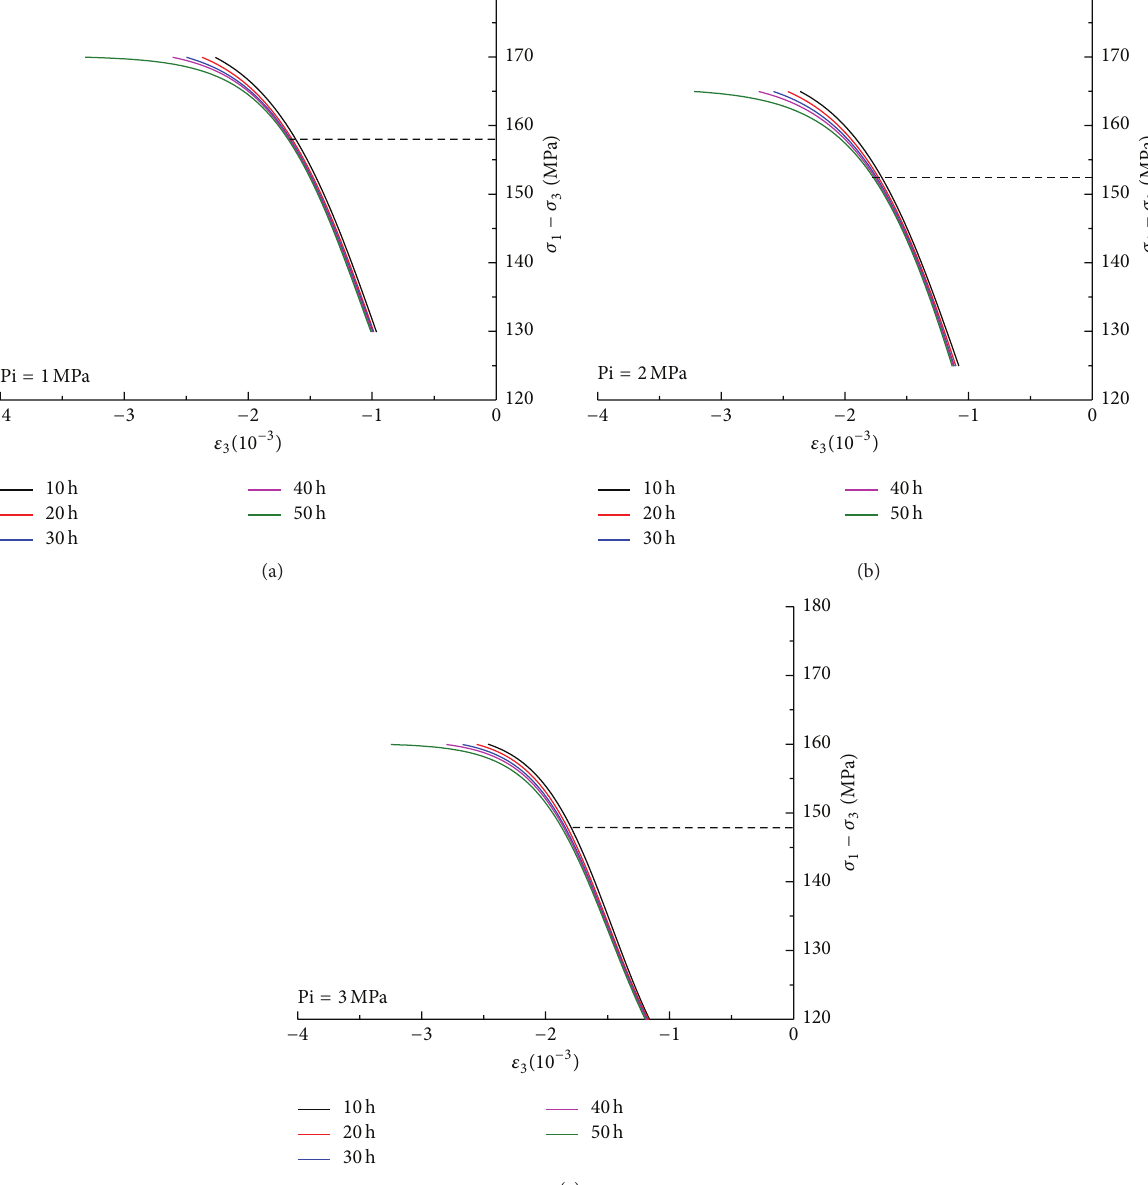
Figure 4: Isochronous stress-lateral strain curves of granite gneiss: (a) 𝜎 3 = 4 MPa, Pi = 1MPa; (b) 𝜎 3 = 4 MPa, Pi = 2MPa; (c) 𝜎 3 = 4 MPa, Pi = 3